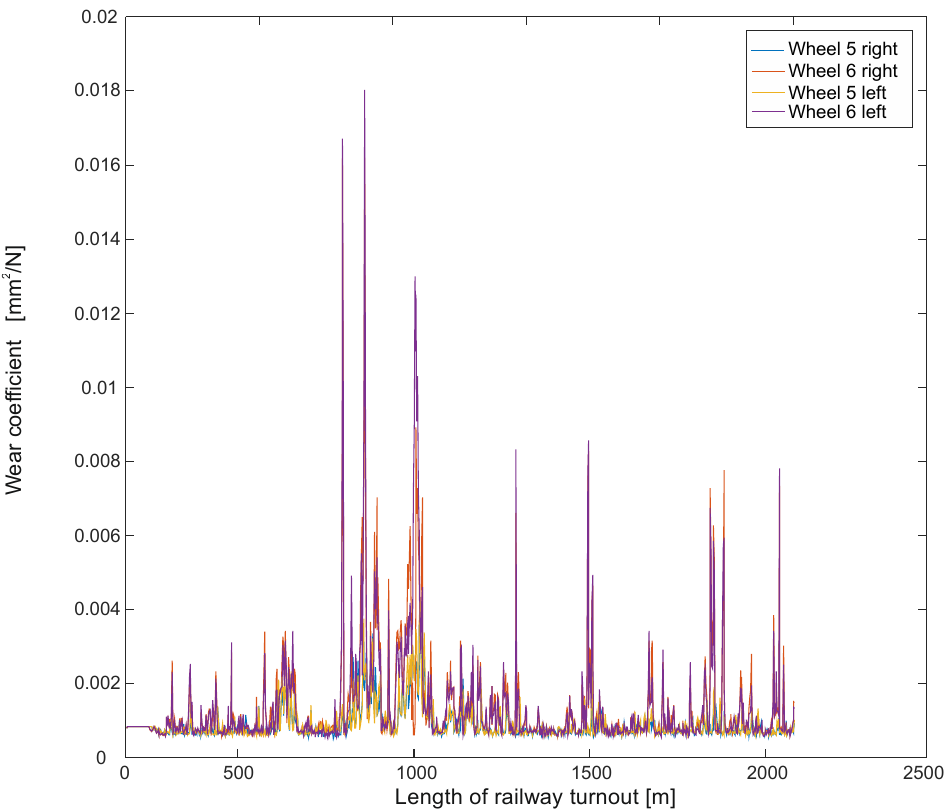
Figure 33. Wear coefficient obtained for a straight track without a turnout at 250 km/h.